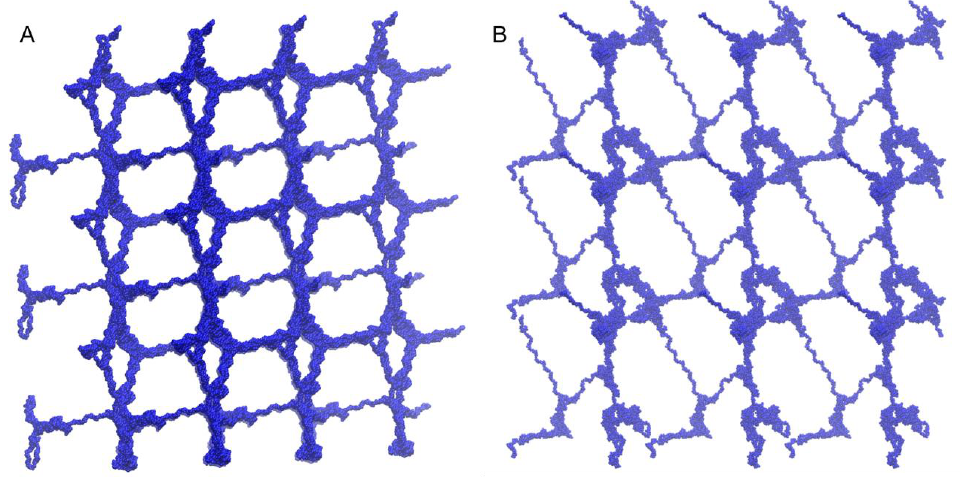
Figure 8. The simulation configuration of HA gel in 100 mM NaCl and: ( A ) 0 mM CaCl 2 ; ( B ) 200 mM CaCl 2 .